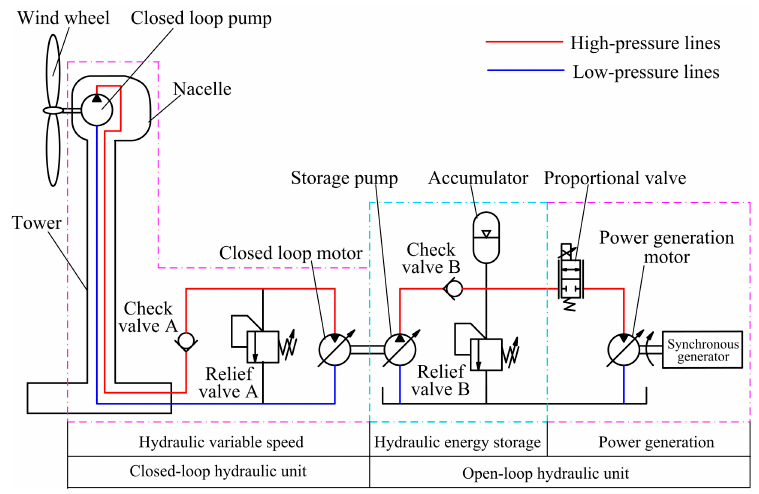
Figure 3. The schematic diagram of the storage type wind turbine.